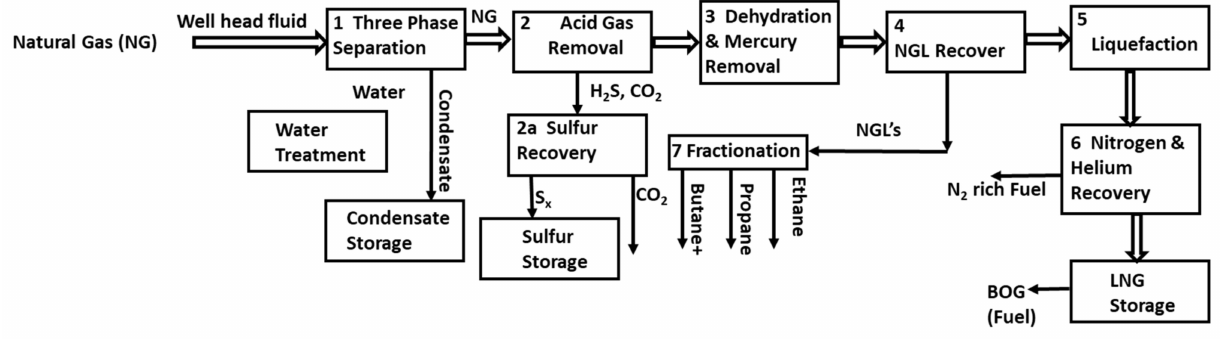
Figure 1. Block diagram showing conventional LNG